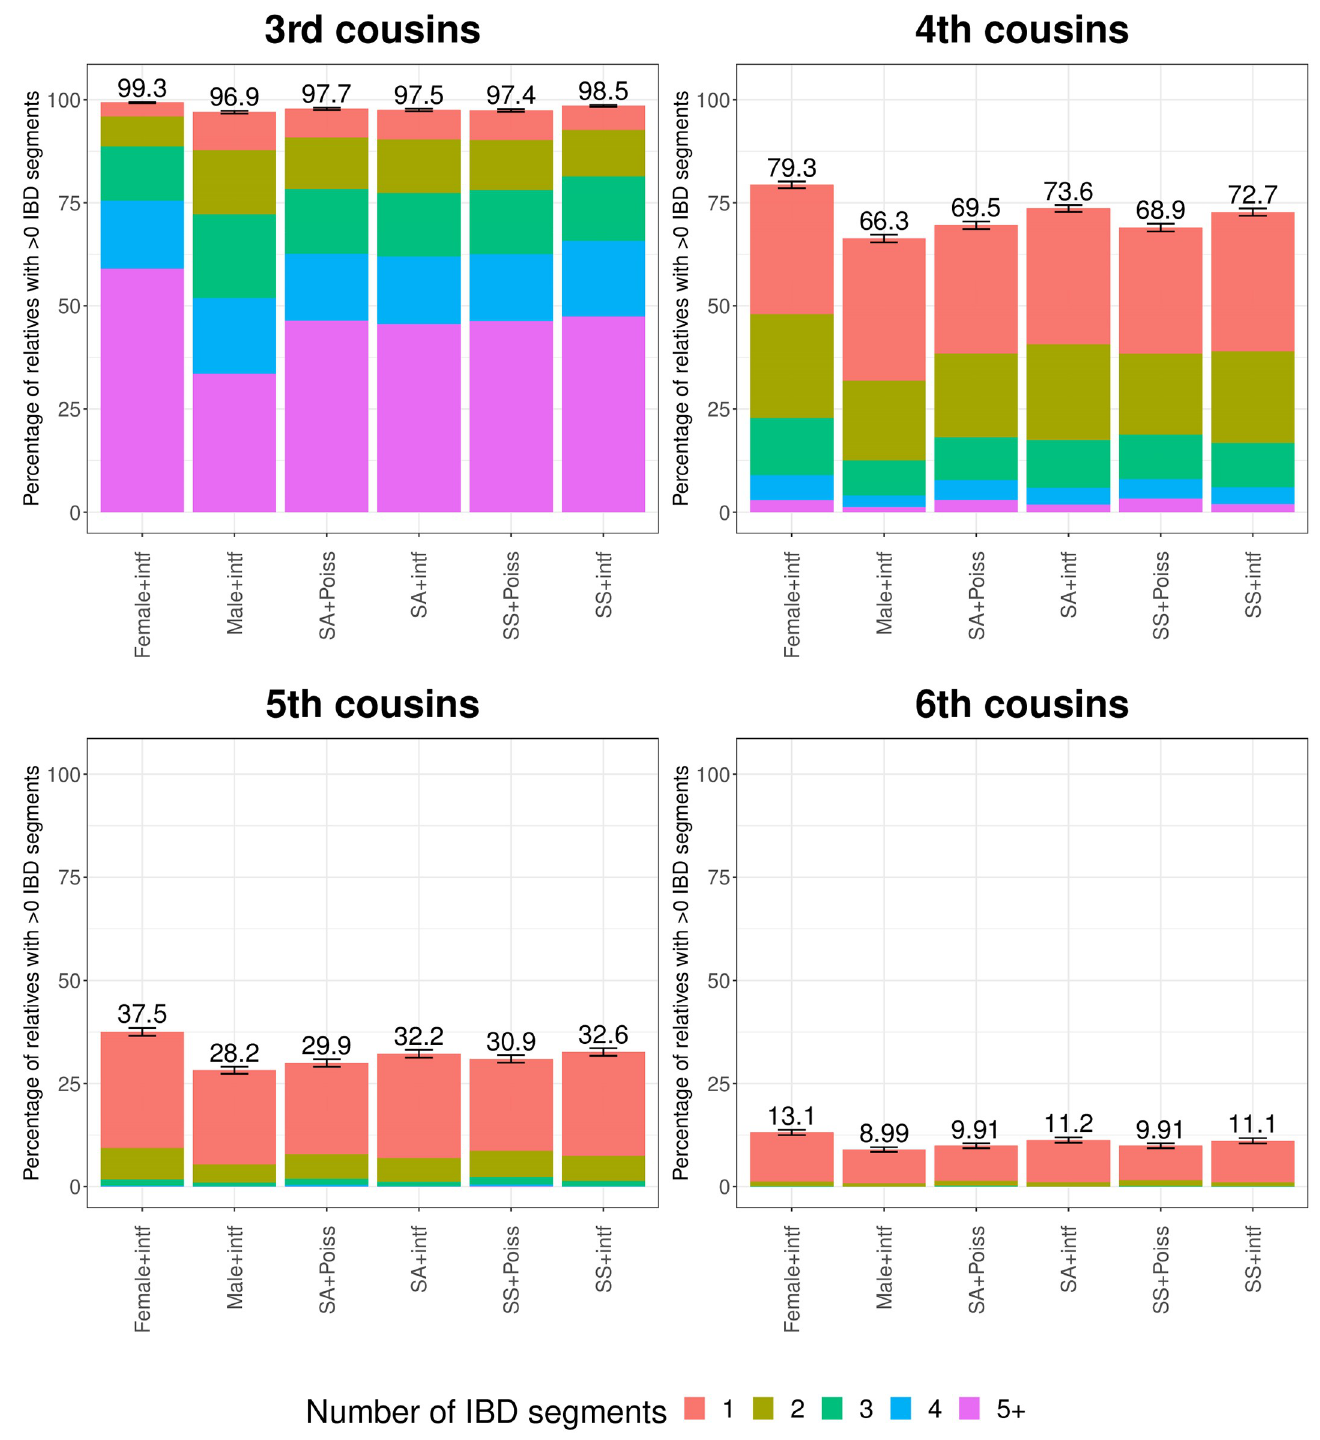
Fig 3. Number of IBD segments that simulated third through sixth cousins share under various modeling scenarios. More distant relatives have reduced rates of sharing one or more IBD regions. Percentages above each bar indicate the fraction of simulated relatives (of 10,000 for each scenario) that have at least one segment shared. Female+intf are from simulations using sex-specific maps and interference but where the pairs are related through only female non-founders, with a male and female couple as founder common ancestors (S8B Fig). Male+intf pairs are the same as Female+intf but with the non-founders being only male instead of female. Error bars are the 95% confidence interval ( ± 1.96 standard errors) of the percentage of relatives that share at least one IBD segment based on 1,000 bootstrap samples. Error on internal bar segment counts are in S10 Fig.